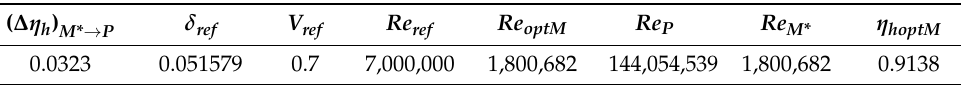
Table 8. Comparison of numerical results and application of tolerances for full- and laboratory- scale models.